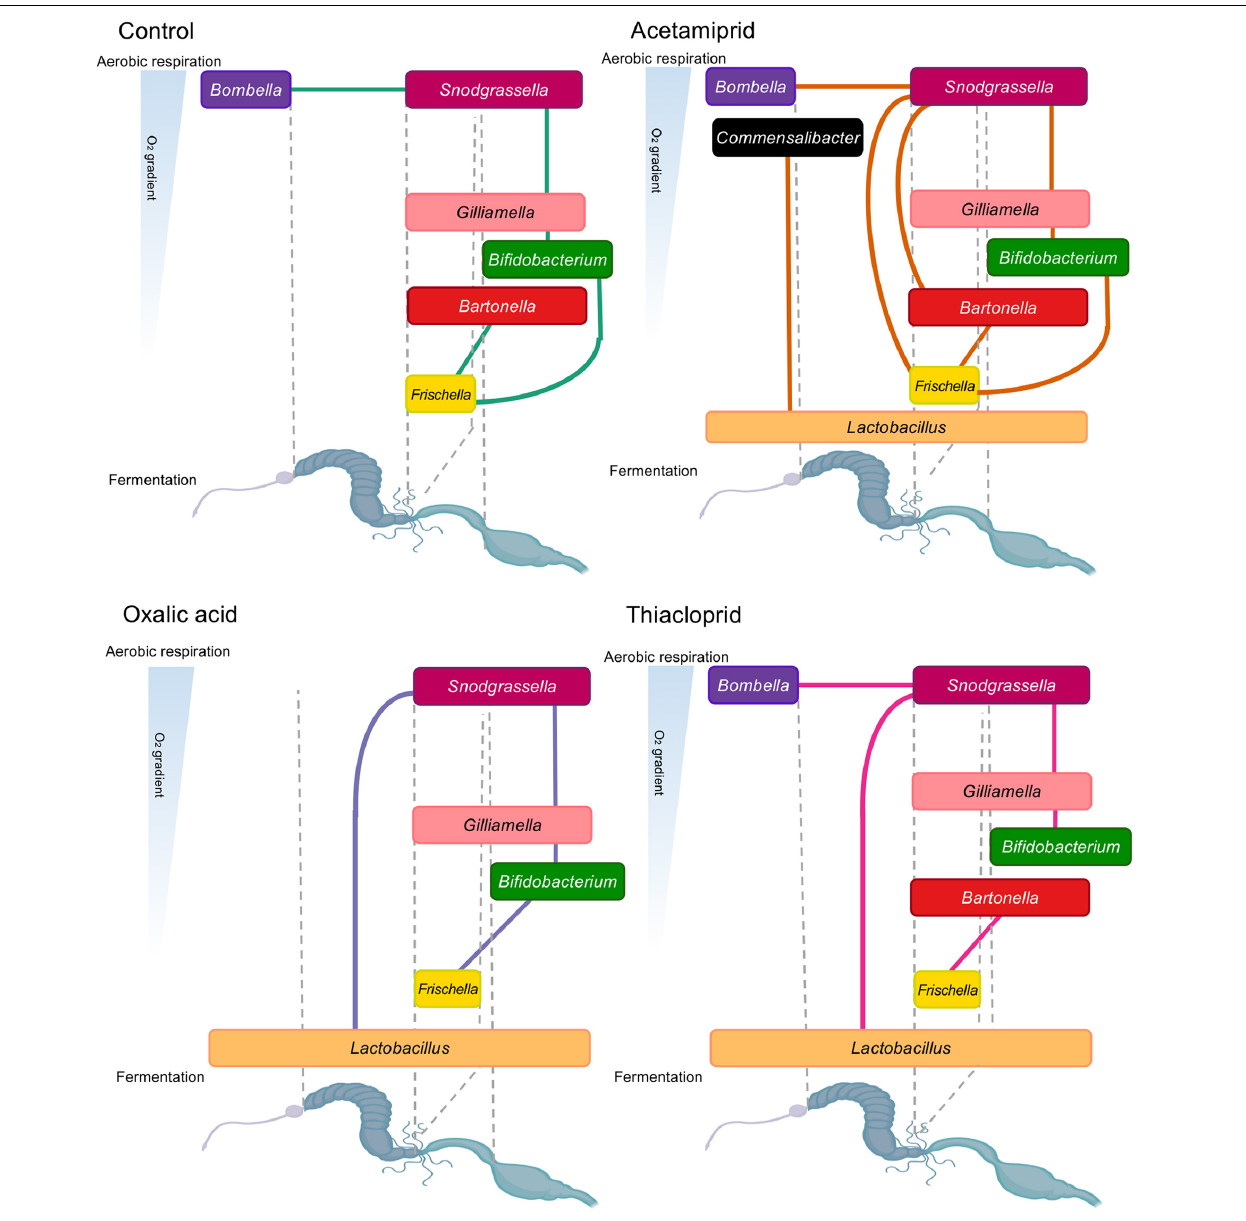
FIGURE 7 | Positive relationships in honeybee gut bacterial genera by experimental treatment. Lines between bacterial genera indicate positive relationships from individual network analyses. The genera are represented based on their oxygen niche ( y -axis) and their position in the gut ( x -axis), with the width of text boxes indicative of their gut placement. The oxygen niche and position in the gut is based on current literature (Anderson et al., 2013; Kwong and Moran, 2016; Butler et al., 2013; Kešnerová et al., 2017; Bonilla-Rosso and Engel,